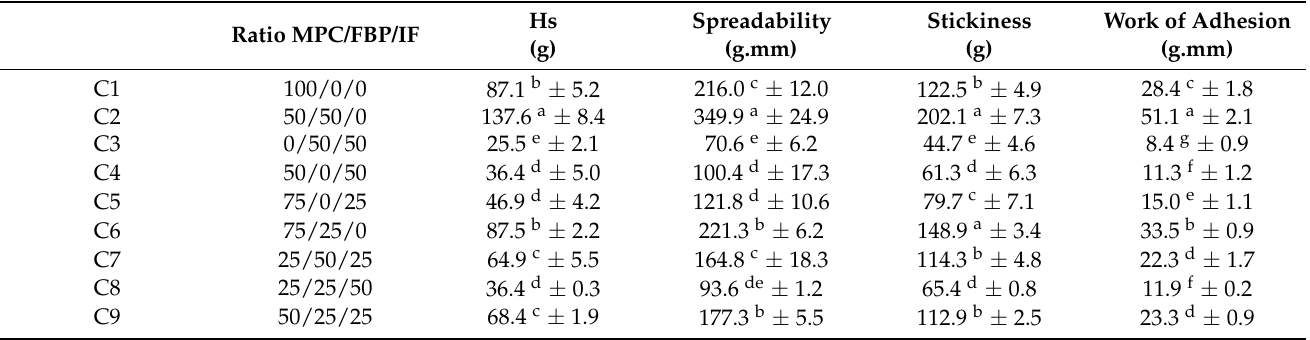
Table 5. Texture properties of the nine spreadable cheese analogues. Values show means ± standard deviations, n =